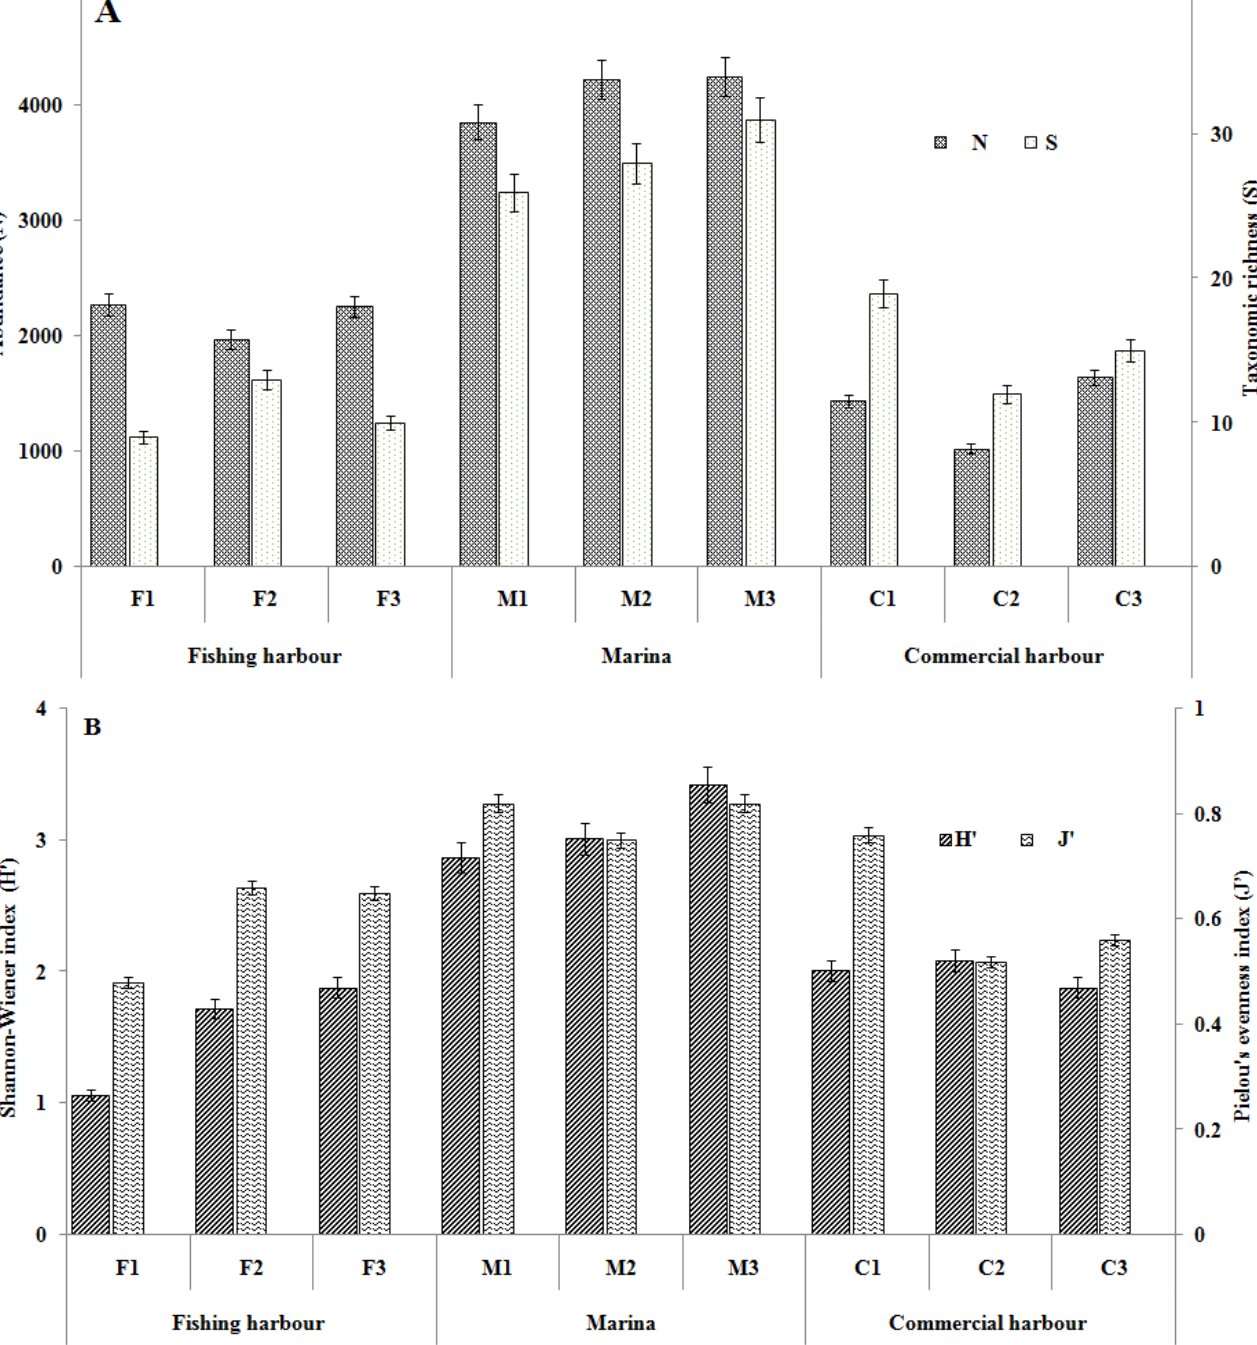
terms of individuals for each sampling site (Figure 4A). A high number of macrobenthic taxa are recorded for Monastir marina (46 taxa), following by the fishing harbour of Mo- nastir (37 taxa), and the commercial harbour of Sousse (28 taxa). A total of five NIS are recorded: the gastropod Cerithium scabridum , the bivalve Ruditapes philippinarum , Pinctada imbricata radiata , Fulvia fragilis , and the decapod Pilumnus minutus , with high abundances in the marina and the commercial harbour, while the nonindigenous gastropod Cerithium scabridum is particularly well represented in the fishing harbour.